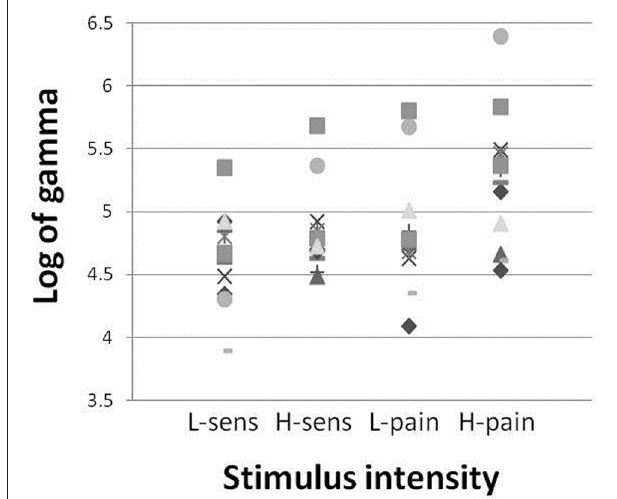
FIGURE 3 | Gamma amplitude vs. stimulation intensity. Gamma (30–80Hz) power increase (log of area under curve of gamma power spectra) with each symbol representing one participant, at each of the stimulation